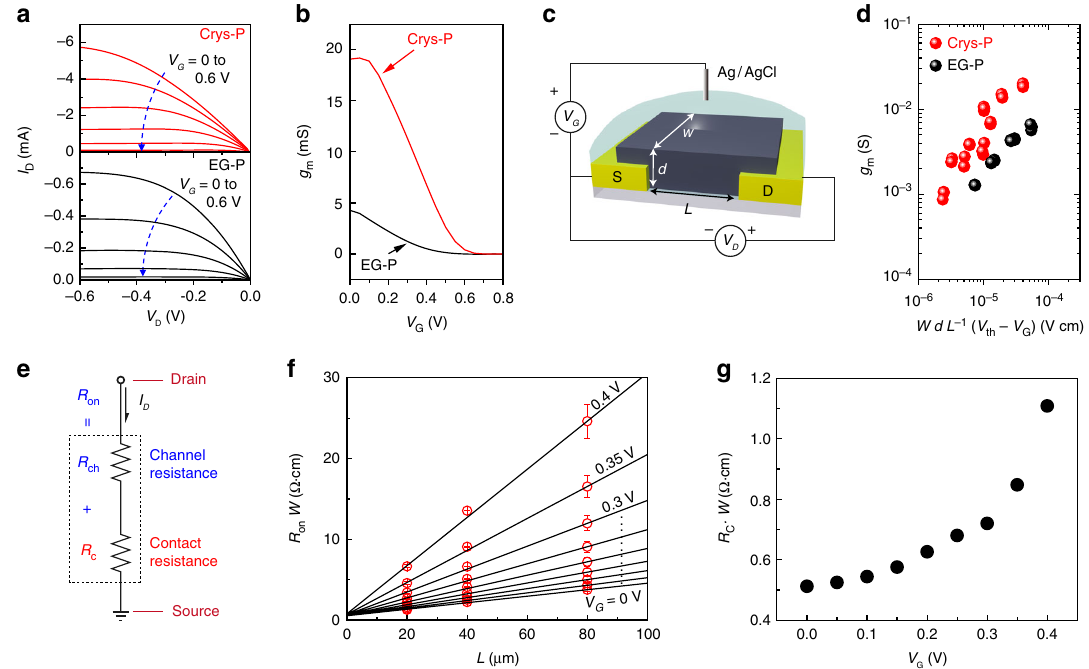
Fig. 3 Electrical characterizations of Crys-P and EG-P OECTs. a Output and b transconductance ( g m ) characteristics of crystallized PEDOT:PSS (Crys-P, red curves) and 5% ethylene glycol-treated PEDOT:PSS (EG-P, black curves) OECT devices. In the output plots, V G was scanned from 0 to 0.6 V along the blue dotted arrow. c a schematic de fi nition of the geometrical parameters in the OECT channel. W , d , and L denote the width, thickness and length of the channels, respectively. d The scattered plots of Cyrs-P (red circles)/EG-P(black circles) g m as a function of applied gate bias and channel geometry [ WdL − 1 ( V th – V g )]. Each data point represents an OECT measurement with a given channel geometry. e A equivalent circuit model for the discrimination between R c and R ch within a transistor channel. f TLM analysis of the Crys-P OECT ( d = 61 nm) with the equivalent circuit model. g The plot of W -normalized R c as a function of V